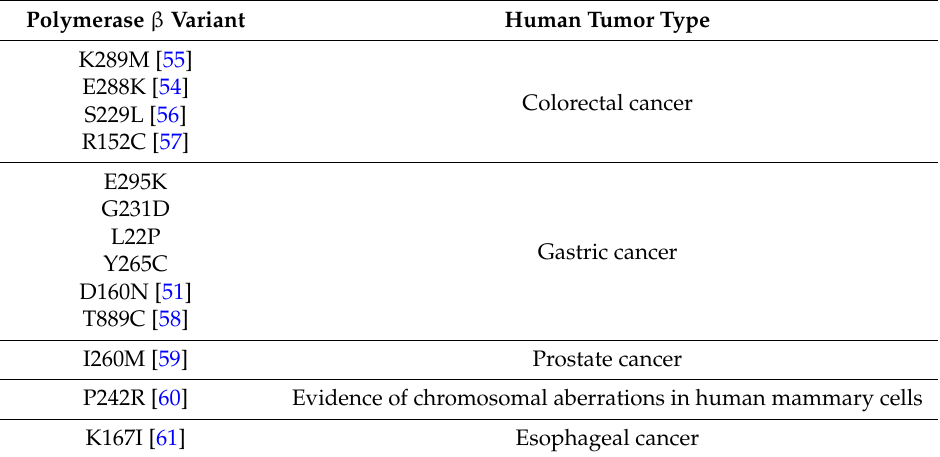
Table 1. Polymerase β variants identified and involved in